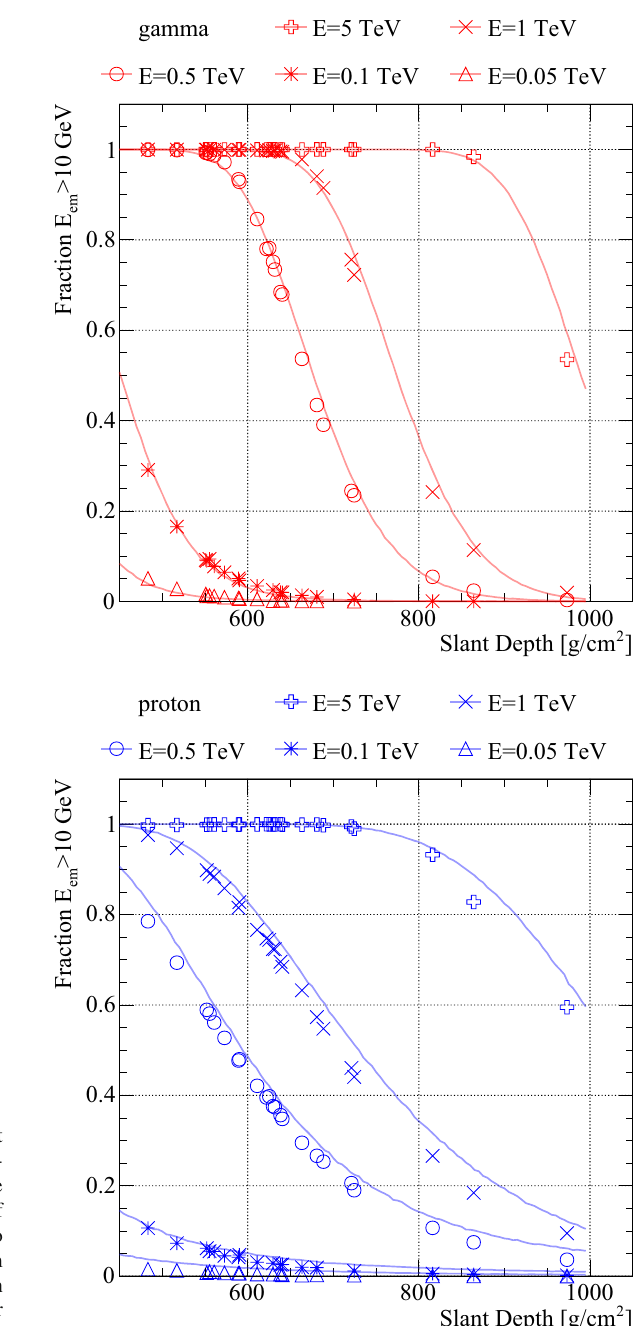
Fig. 7 The fraction of showers that have E em > 10 GeV as a function of slant depth. Top: γ -ray induced showers. Bottom: proton induced showers. The markers are obtained from the full simulation set, while the lines are obtained using the parameterisation based on the fitted behaviour from Figs. 5 and 6. Each data point corresponds to the slant depth of a combination of zenith angle and ground-level from Fig.